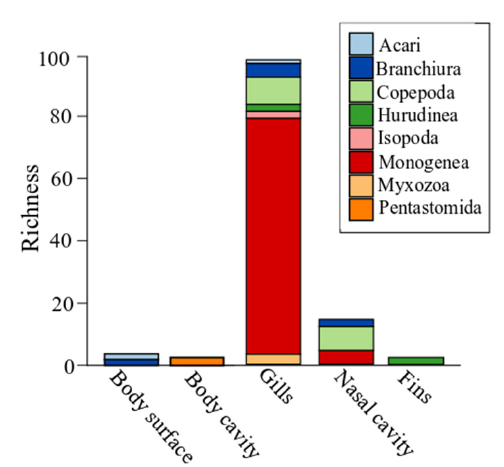
Figure 5. Richness of ectoparasite taxons recorded on the outer surface of the upper Paraná River floodplain hosts.